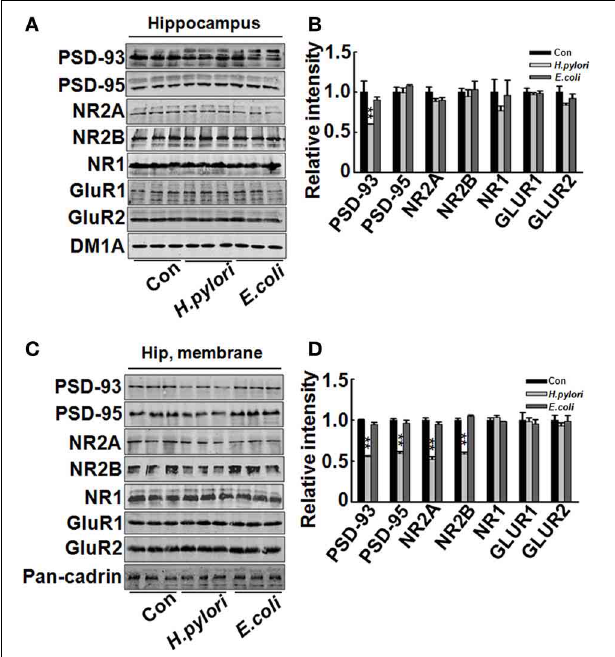
FIGURE 5 | Intraperitoneal injection of H. pylori filtrate induces decreased expression of synaptic proteins in rat hippocampus. SD rats were intraperitoneally injected with H. pylori filtrate, E.coli filtrate, or DMEM/Opti-MEM medium (280 μ l/rat/day) for 7 days as described in Figure 1A .Three rats were then anesthetized and decapitated and extracts of rat hippocampus were prepared and the synaptic receptor and scaffolding protein levels were measured by Western blotting with site-specific antibodies. DM1A and Pan-Cadherin were loaded as cytoplasm and membrane protein controls separately. Fifteen micrograms of protein samples were loaded for PSD-93, PSD-95, NR2A, NR2B, and Pan-Cadherin, 20 μ g of proteins were loaded for NR1, GluR1 and GluR2, and 5 μ g for DM1A. (A,B) The total protein level of PSD-93 was significantly decreased in H. pylori filtrate-injected rat brains ( p = 0 . 004, F = 10 . 015), while PSD-95, NR2A, NR2B, NR1, GluR1, and GluR2 showed no difference among the three groups ( A , representative bands; B , quantitative analysis of the density). (C,D) The membrane proteins in the rat hippocampus were extracted and synaptic proteins were detected by Western blotting. H. pylori filtrate injection induced remarkable decrease of membrane NR2A, NR2B, PSD-93, and PSD-95 levels ( C , representative bands; D , quantitative analysis of the density, p -value: PSD-93, p = 0 . 002, F = 13 . 189; PSD-95, p = 0 . 001, F = 18 . 183; NR2A, p = 0 . 001, F = 21 . 32; NR2B, p = 0 . 008, F = 13 . 808). All the experiments were repeated at least three times. ∗ p < 0 . 01 vs. control group (mean ± SD, n = 3).